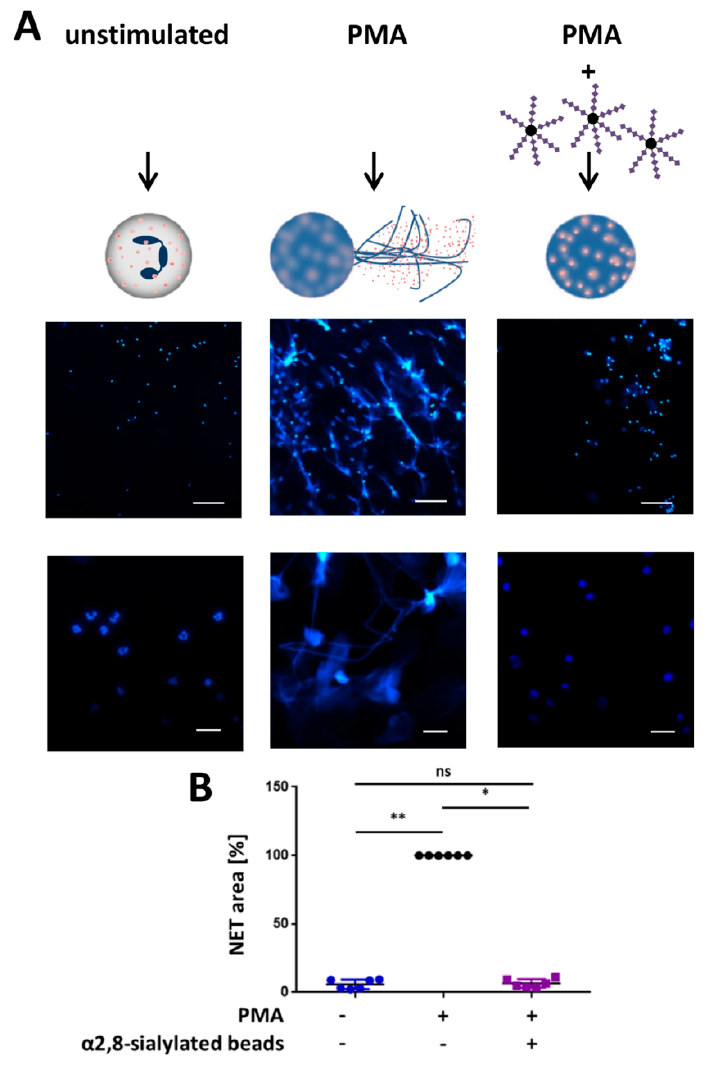
Figure 4. α 2,8-sialylated particles inhibit NET release. ( A ) Fluorescence staining (DAPI; blue) of neutrophils without any stimulation of neutrophils, stimulated with 20 nM PMA for 4 h, and of neutrophils stimulated with 20 nM PMA coincubated with α 2,8-sialylated particles for 4 h. Upper scale bar: 100 µm, lower scale bar: 20 µm. ( B ) Analysis of the NET area (%). The analysis was performed using Cell Profiler 2.2.0. The NETosis area (%) was calculated by determining the blue fluorescent areas (DAPI). PMA inducement was set to 100%. Mean values ( n = 6) and standard deviations are displayed. The Kruskal–Wallis test and Dunn’s test for multiple comparisons were applied. Statistically significant differences are given as follows: ns, not significant, * p ≤ 0.05 and ** p ≤ 0.01.